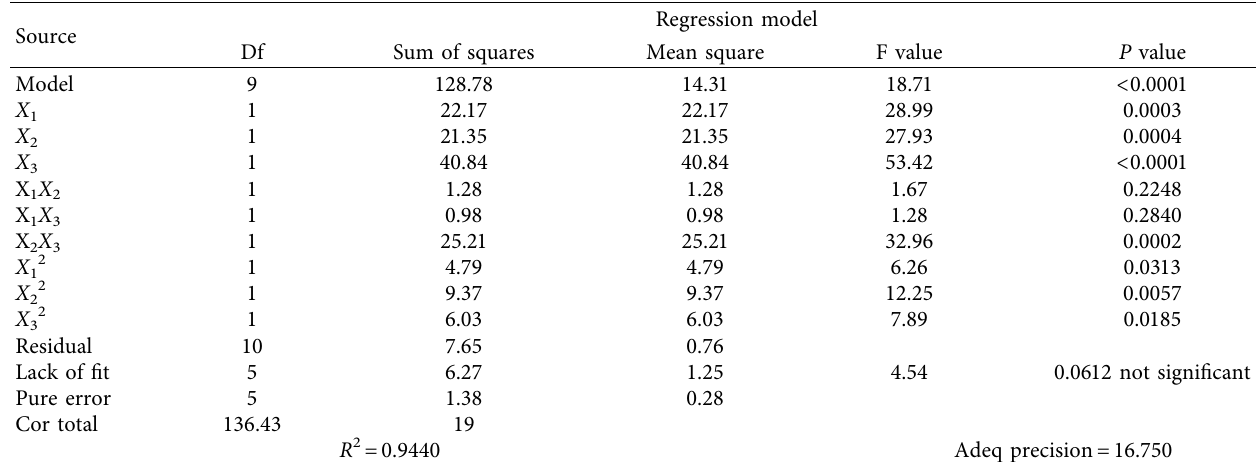
Table 10: Variance analysis TABLE of regression